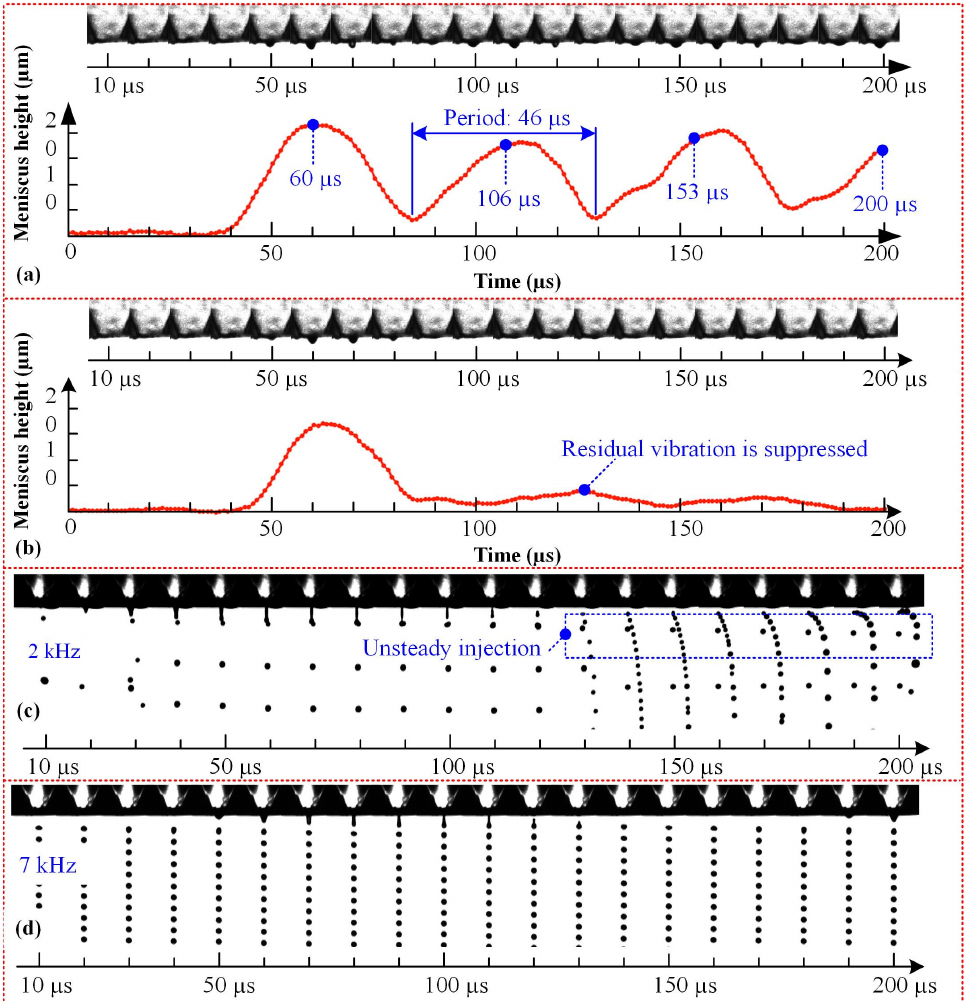
Figure 7. ( a ). Meniscus vibration process corresponding to STDW. ( b ). Meniscus vibration process corresponding to the optimized waveform. ( c ). At 2 kHz frequency, the droplet ejection process corresponding to STDW is unstable. ( d ). At 7 kHz frequency, the droplet ejection process corresponding to the optimized waveform is stable.